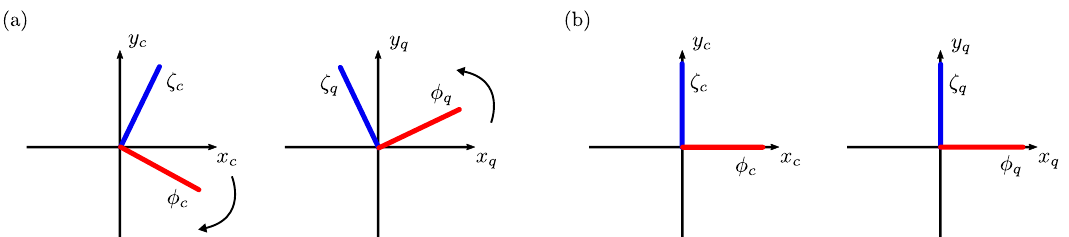
Figure 4: Schematic representation of the massless and massive fields φ and ζ in terms of the x and y fields that represent ˆ S and ˆ S . (a) The gapped / gapless fields x y are shown at a generic critical point. The classical and quantum fields are rotated with respect to the x - y axes, but in opposite directions, a fact that leads to the oppo- site signs of the effective temperatures. (b) At the weakly-dissipative critical point, ∆ = 2 J , Γ → 0, the gapless and gapped fields align with the x and y axes, respec- tively, similar to thermal